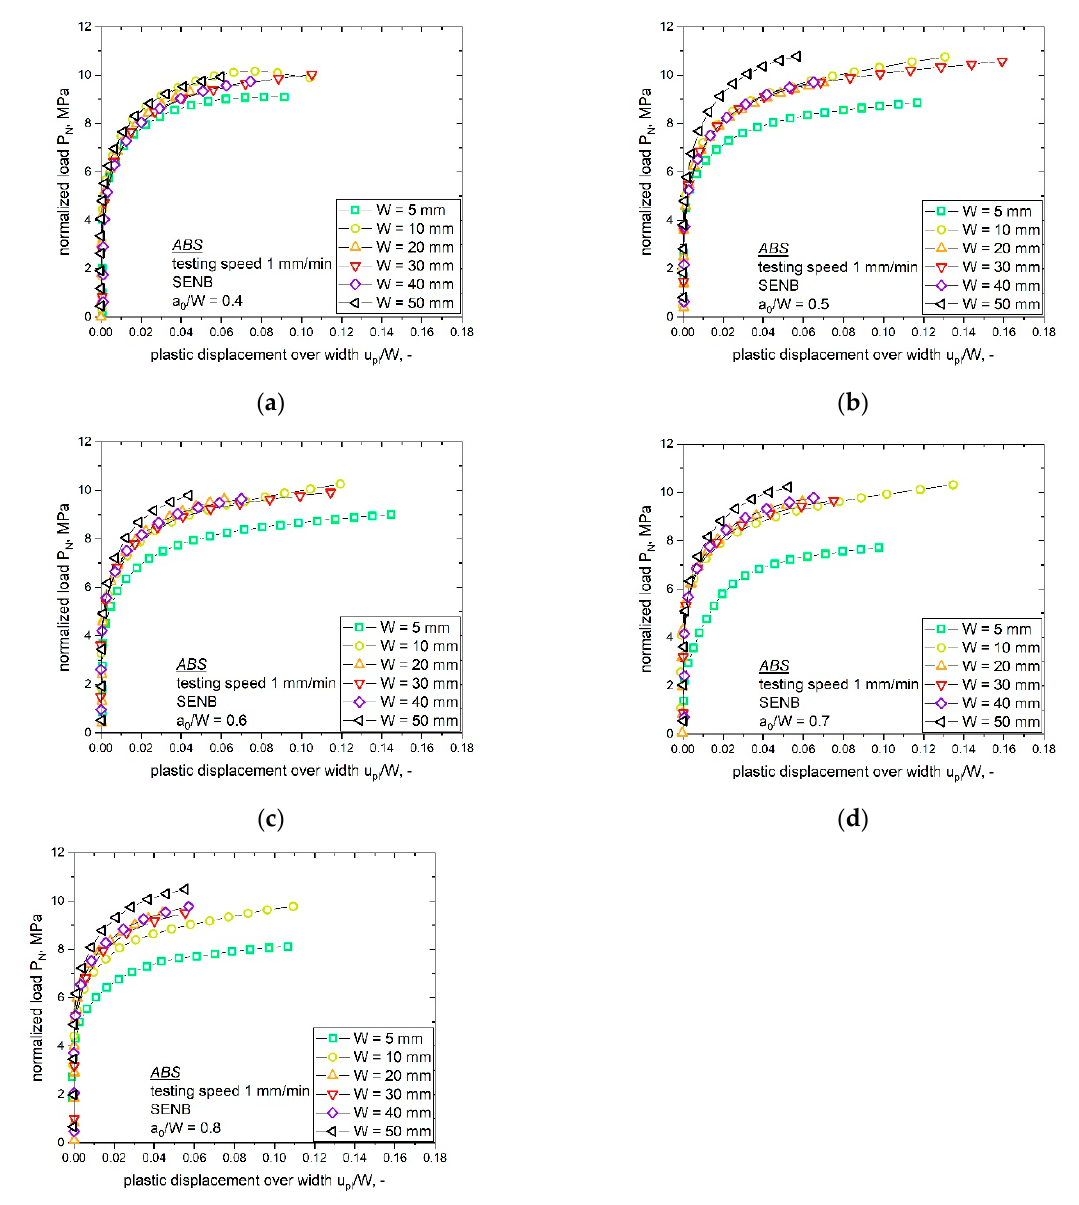
Figure 9. Material key curves for the investigated bN ABS specimens with different sizes (W of 5, 10, 20, 30, 40 and 50 mm) and varying a 0 /W ratios of 0.4 ( a ), 0.5 ( b ), 0.6 ( c ), 0.7 ( d ) and 0.8 ( e ).